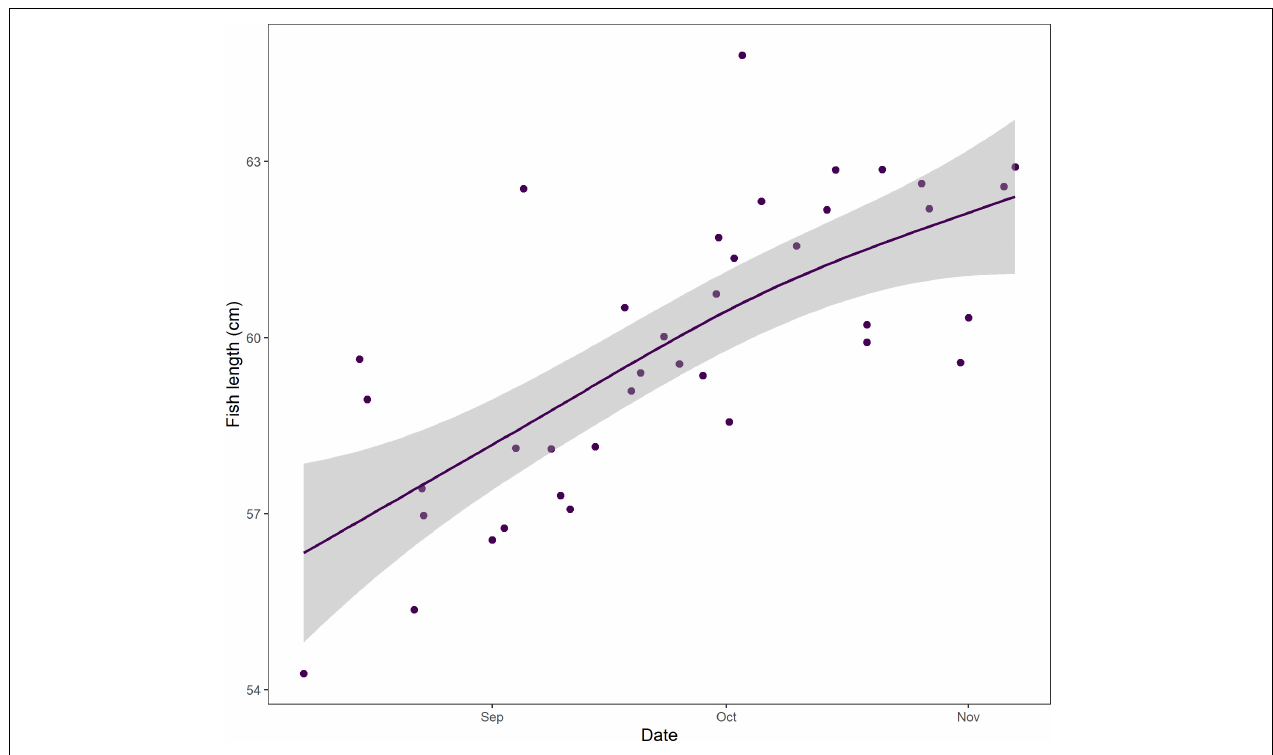
FIGURE 6 | Relationship between the date of the end of the annual salmon run (95% quantile) through the upstream Burrishoole traps, and the average length of wild female grilse kelts of that cohort. The line indicates a GAM of the relationship and the gray areas indicate the 95% confidence interval of the predications.